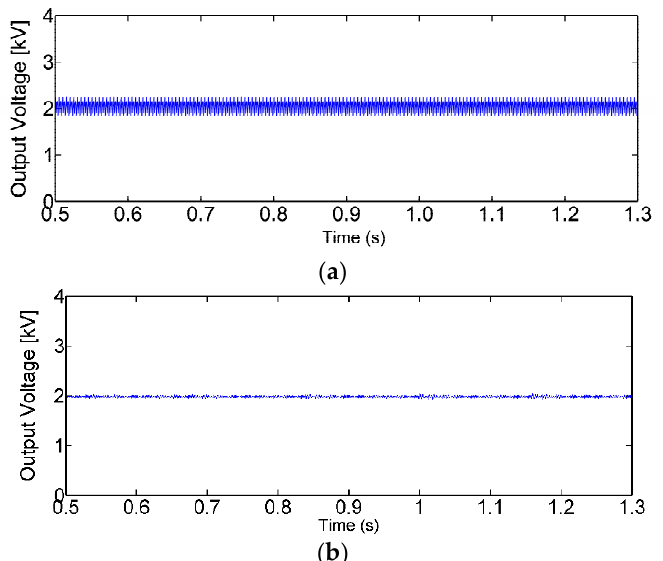
Figure 11. Comparison of the output voltages for different DC-DC MMC topologies when r = 0.5. ( a ) Output voltage of the DC-DC MMC without adopting the middle cells. ( b ) Output voltage of the proposed DC-DC MMC.